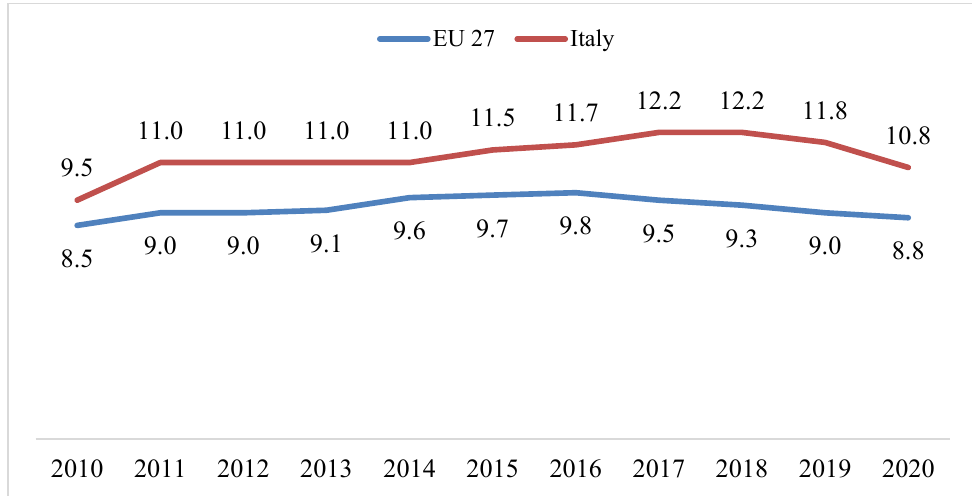
Figure 8. In-work poverty in Europe and Italy, 2008–2020. Source: own elaboration on the Eurostat database.